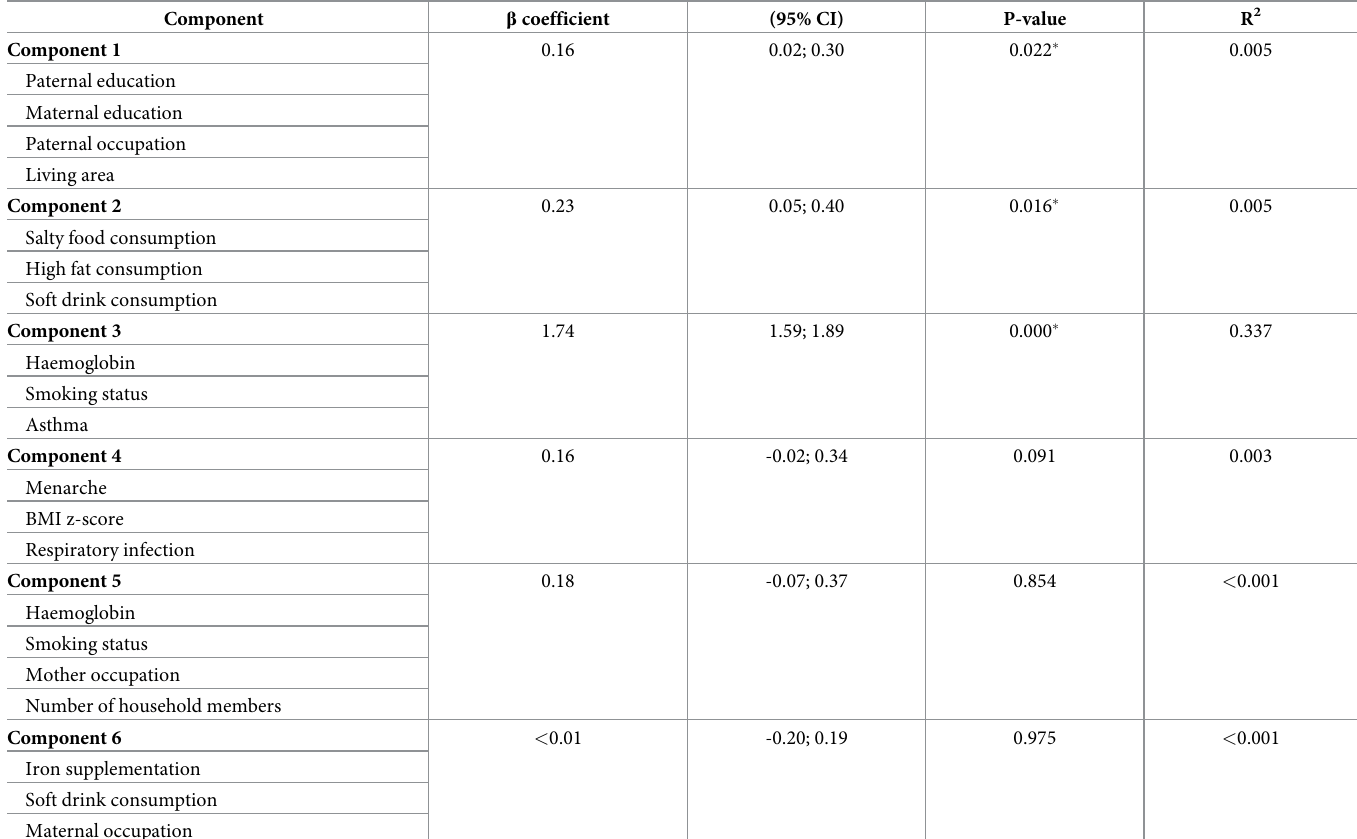
Table 3. Results of principal component regression of six retained